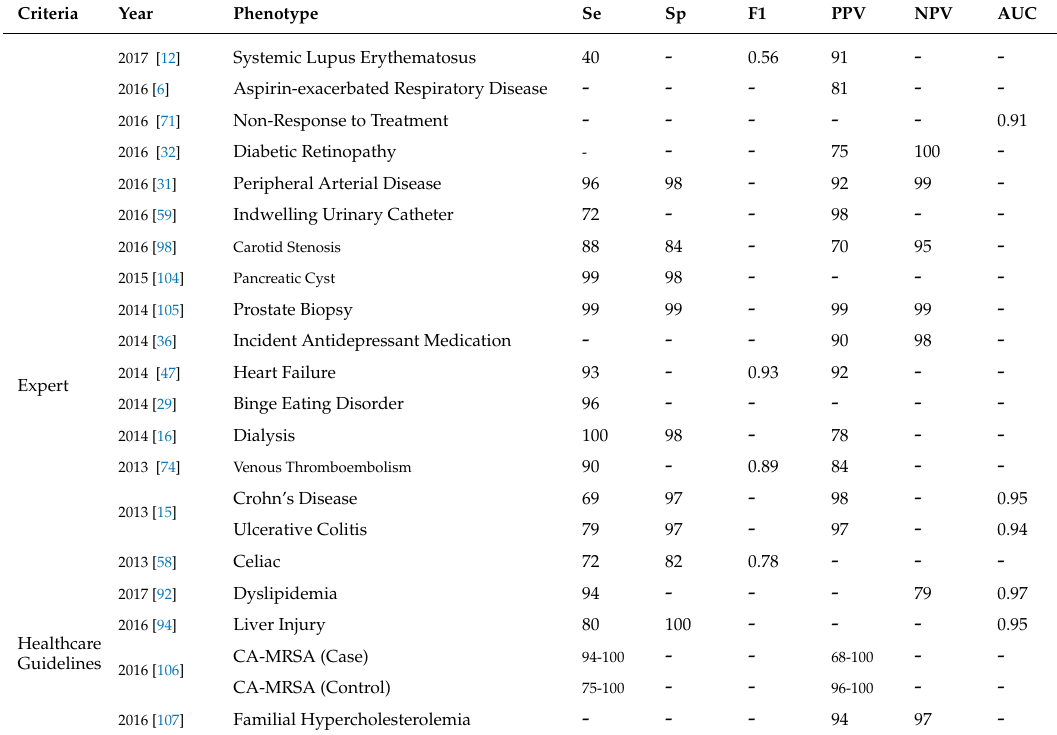
Table 3. List of studies using Rule-based systems as a classification technique.